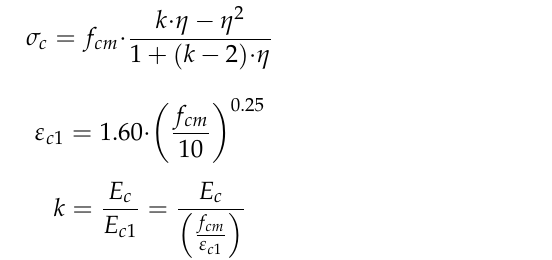
Figure 4. Notched cross-section with exponential law of the reduced width, 𝑏 𝑘 , in the transition zone, 𝑙 𝑡 : ( a ) linear expression ( 𝛼 = 1) of 𝑏 𝑘 , ( b ) exponential expression with 𝛼 > 1 , ( c ) exponential expression with 𝛼 < 1 .